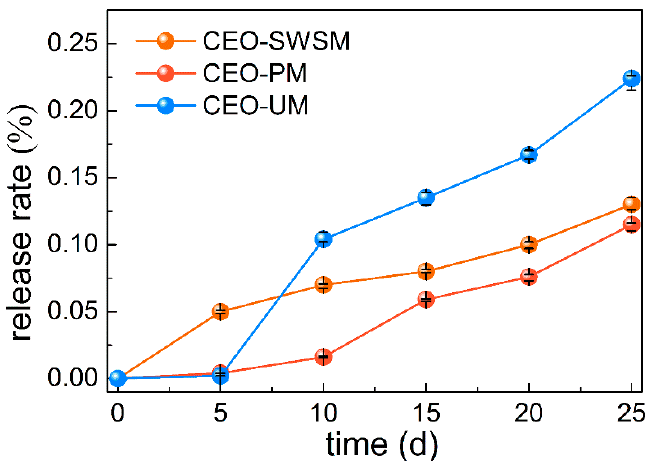
Figure 7. Release rates of the microcapsules synthesized by saturated aqueous solution method (CEO-SWSM), molecular inclusion method (CEO-PM), and ultrasonic method (CEO-UM).